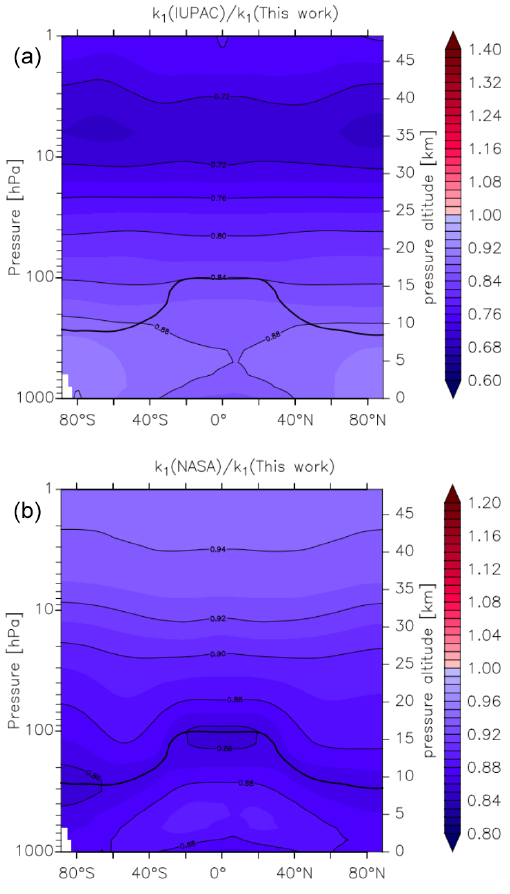
Figure 15. Effect of different parameterizations of k 1 on the (a) and k 1 (NASA) (b) . Figure 14. Global values of k 1 (IUPAC) k 1 (this work) k 1 (this work) global (zonal and yearly averaged) H 2 SO 4 to SO 2 ratio. Panel k 1 was calculated using the parameters from this work and those (a) plots H 2 SO 4 (IUPAC) / H 2 SO 4 (this work), and panel (b) plots presently recommended by the IUPAC and NASA data evaluation SO 2 SO 2 H 2 SO 4 panels. The relatively thick black line between 300 and 100hPa rep- (NASA) / H 2 SO 4 (this work). The relatively thick black line SO 2 SO 2 resents the mean model tropopause. between 300 and 100hPa represents the mean model